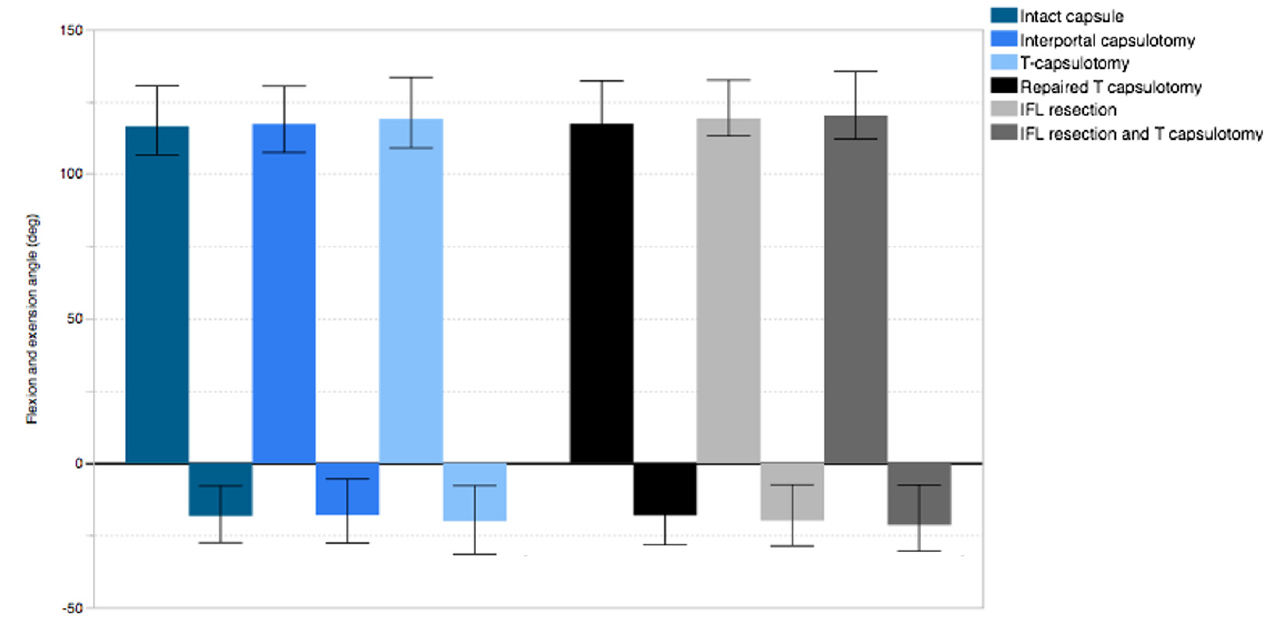
Figure 3. Flexion and extension angle in different capsule conditions.